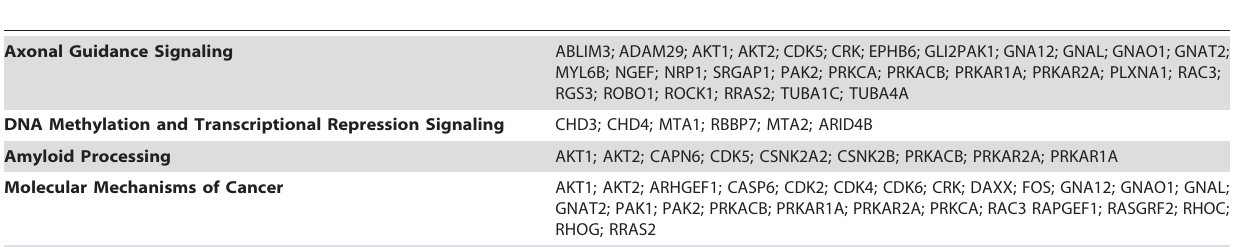
Table 1. List of proteins identified by LC MS/MS in CD105 + cells that participate in specific canonical pathways as determined by IPA